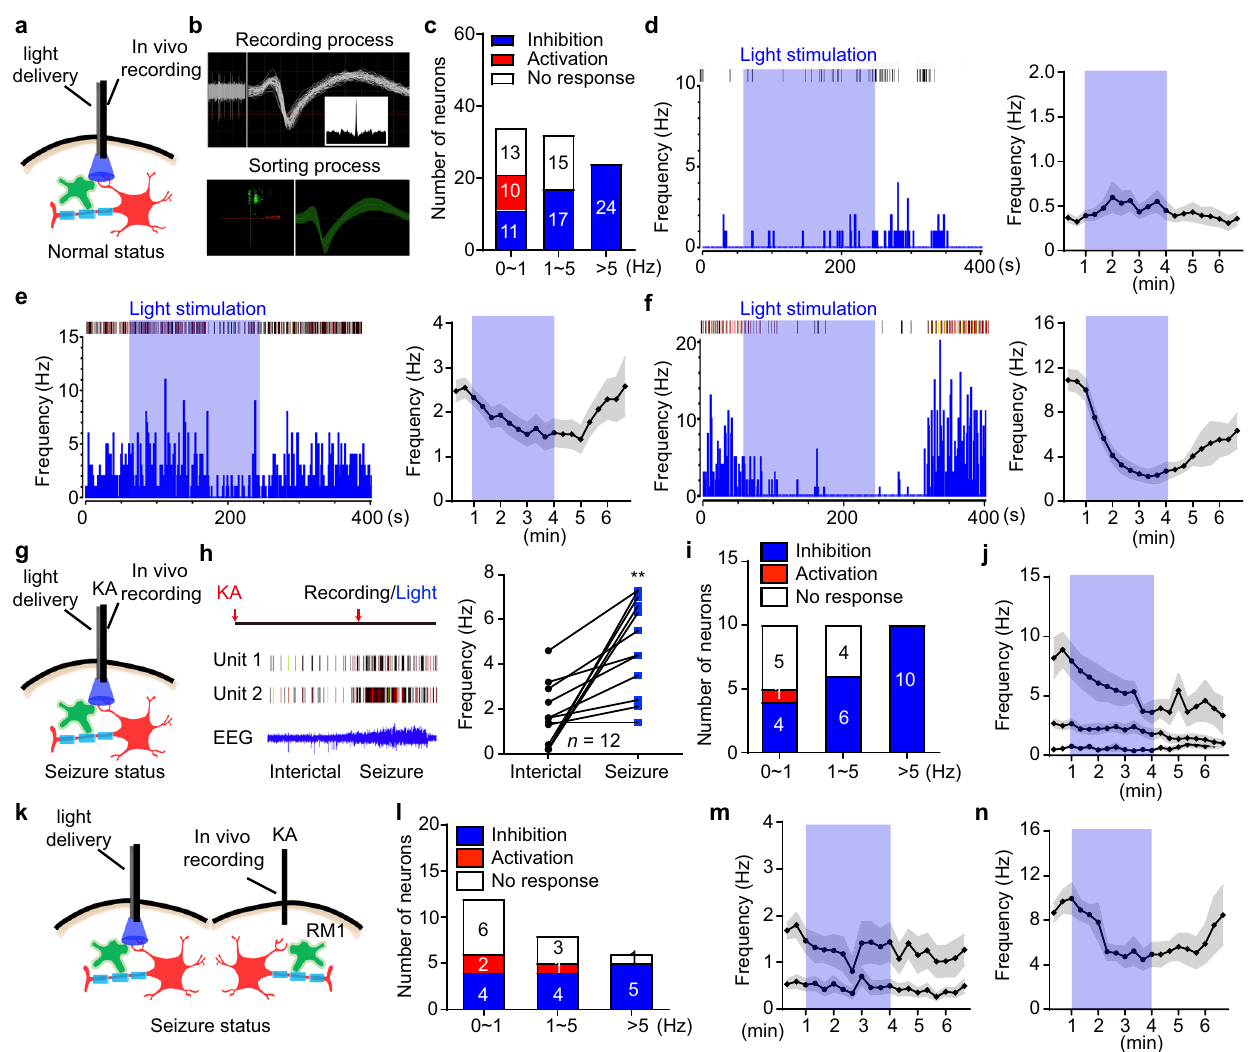
Fig. 2 | Optogenetic stimulation of ChR2-expressing astrocytes activity- dependently inhibits fi ring of pyramidal neurons. a Schematic of in vivo single- unit recording in naïve GFAP-ChR2 M1 mice. Astrocyte (green), Neuron (red). b The onlinerecordingprocessandof fl inesortingprocessofinvivosingle-unitrecording of putative pyramidal neuron with wide waveform. Inset panel, corresponding protrude autocorrelation of a representative putative pyramidal neuron. c Summary data of the responses of recorded M1 pyramidal neurons during astrocyte stimulation. d – f Representative peri-event raster histograms and time- frequency statistical charts showed the response of blue light stimulation in dif- ferent frequency groups. g Schematic of in vivo single-unit recording in GFAP- ChR2 M1 mice in KA-induced seizure status. h Left panel, representative spikes and local fi eldpotentials of M1 pyramidalneurons during interictaland seizurephases. Right panel, quanti fi cation of the frequency of M1 pyramidal neurons during